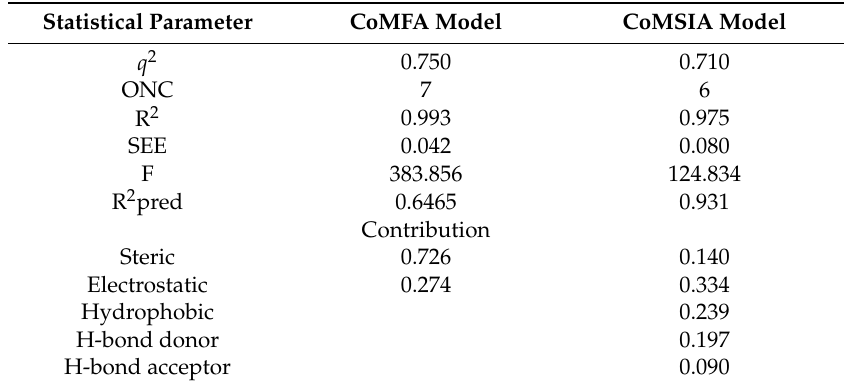
Table 3. Summary of the results obtained from CoMFA (comparative molecular field analysis) and CoMSIA (comparative molecular similarity index analysis) analyses.